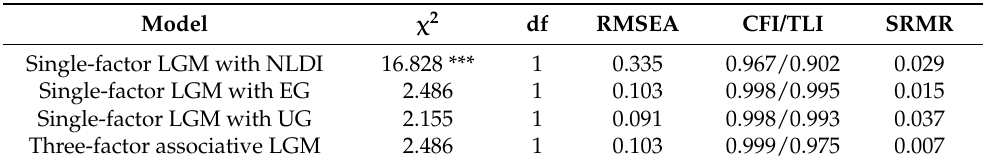
Table 2. Model fit indices including root mean square error of approximation (RMSEA), comparative fit index (CFI), Tucker–Lewis index (TLI), and standardized root mean square residual (SRMR) for latent growth models (LGMs) based on Education Gini (EG) and Urban Population Gini (UG), and Nighttime Light Development Index